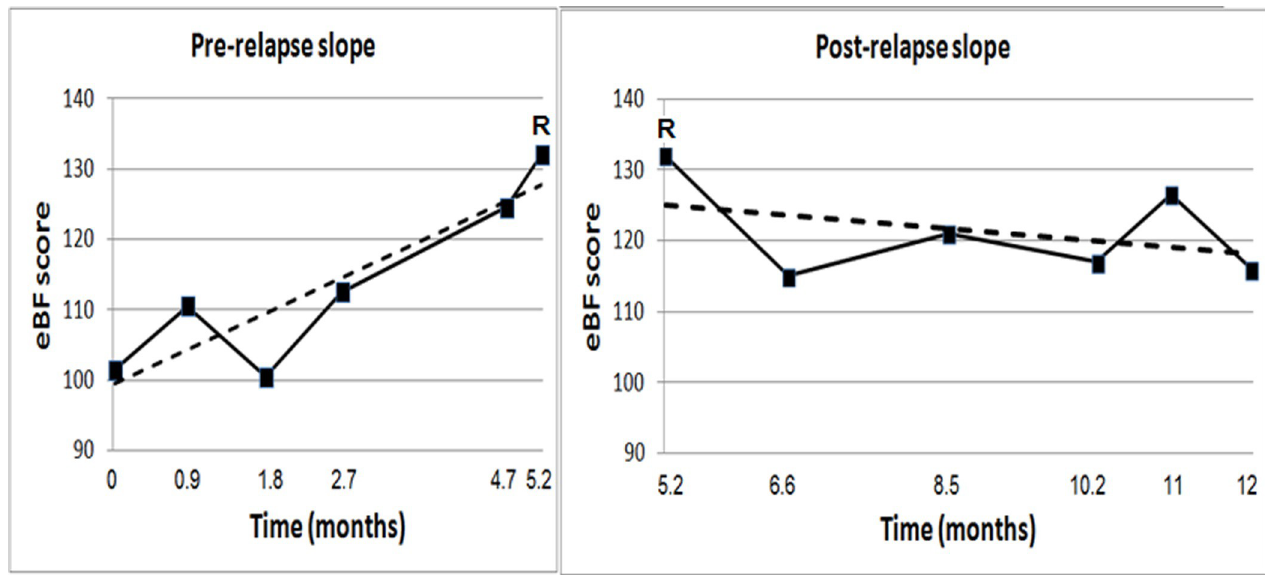
Fig 1. Pre- and post-relapse regression slopes: Illustration for one patient. The sum scores of e-diary derived bodily function PROs by time since study entry from a single participant are shown. This patient had an on-study relapse about 5 months after enrolment to the study (marked by the letter ’R’). The trend of change in bodily function PROs score is depicted by the dashed line, which represents the individual regression slope [33]. The pre-relapse regression slope (left panel) is positive, indicating worsening, while the post-relapse regression slope (right panel) is negative, indicating improvement.